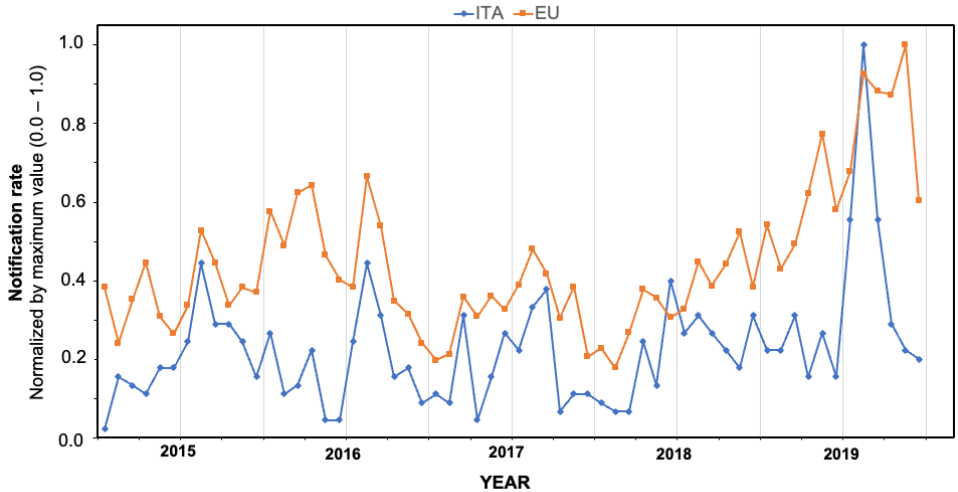
Figure 1. Comparison of Italian and European data for dengue in the time period 2015–2019, monthly incident cases, normalized by maximum value.